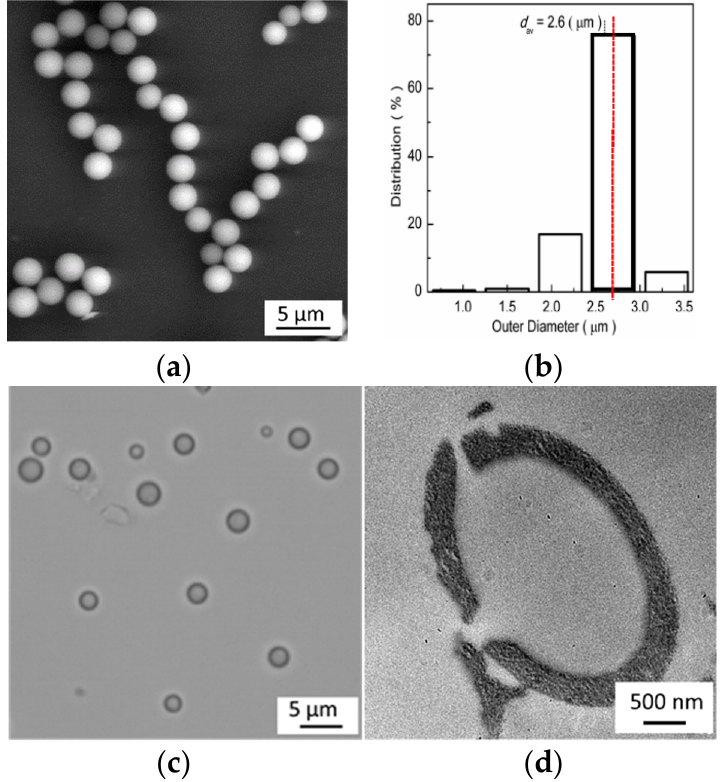
Figure 1. The SEM image ( a ), size distribution ( b ), and CSLM optical micrograph ( c ) of the hollow microspheres obtained by irradiating 0.01 mol L − 1 DCH18C6 for 167 h, respectively, and TEM image of the ultra-thin section of the hollow microspheres ( d ).